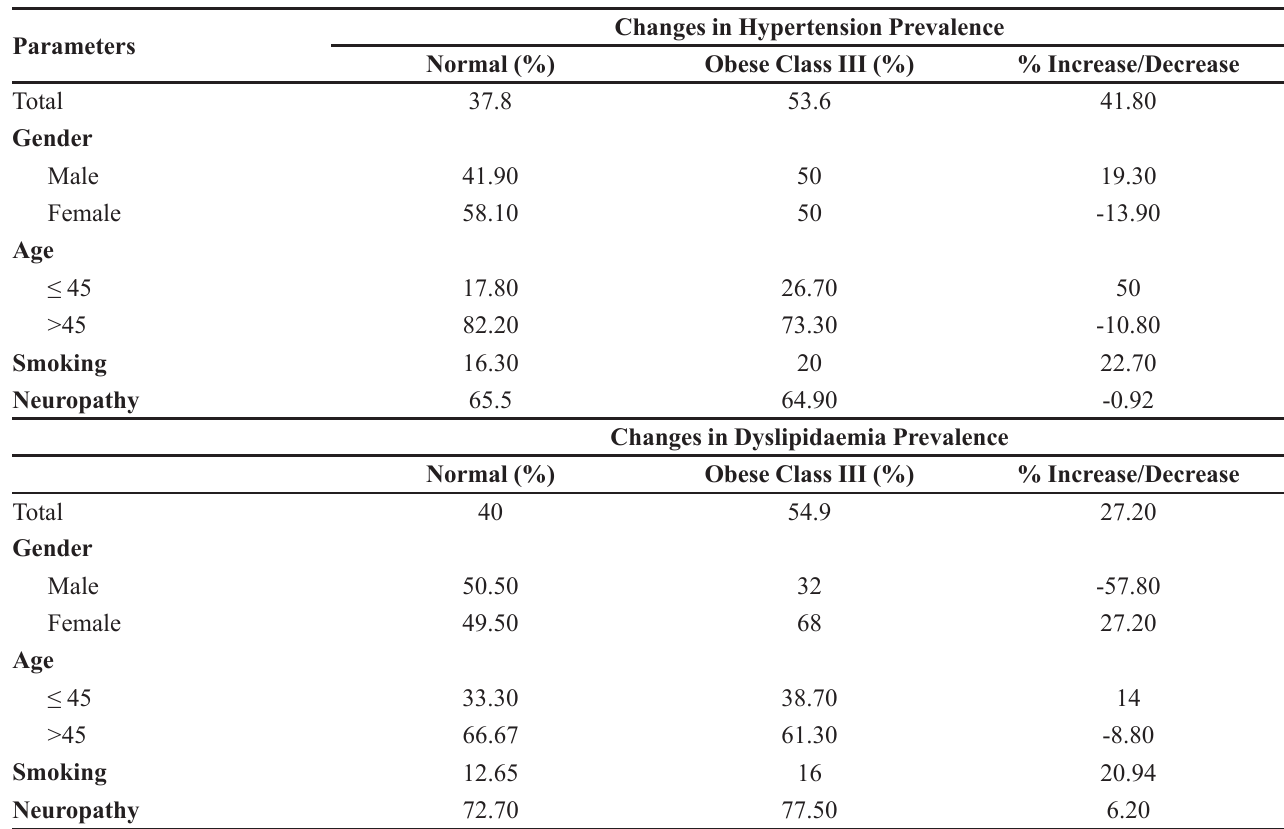
TABLE IV - Changes in hypertension & dyslipidaemia prevalence by obesity class Parameters